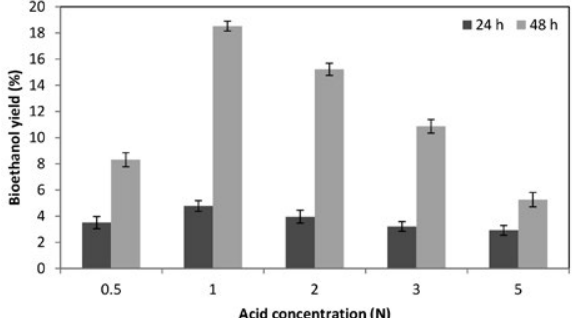
Fig 2. Bioethanol yields obtained from acid pre-treated (at 100 °C, 60 min) microalgae